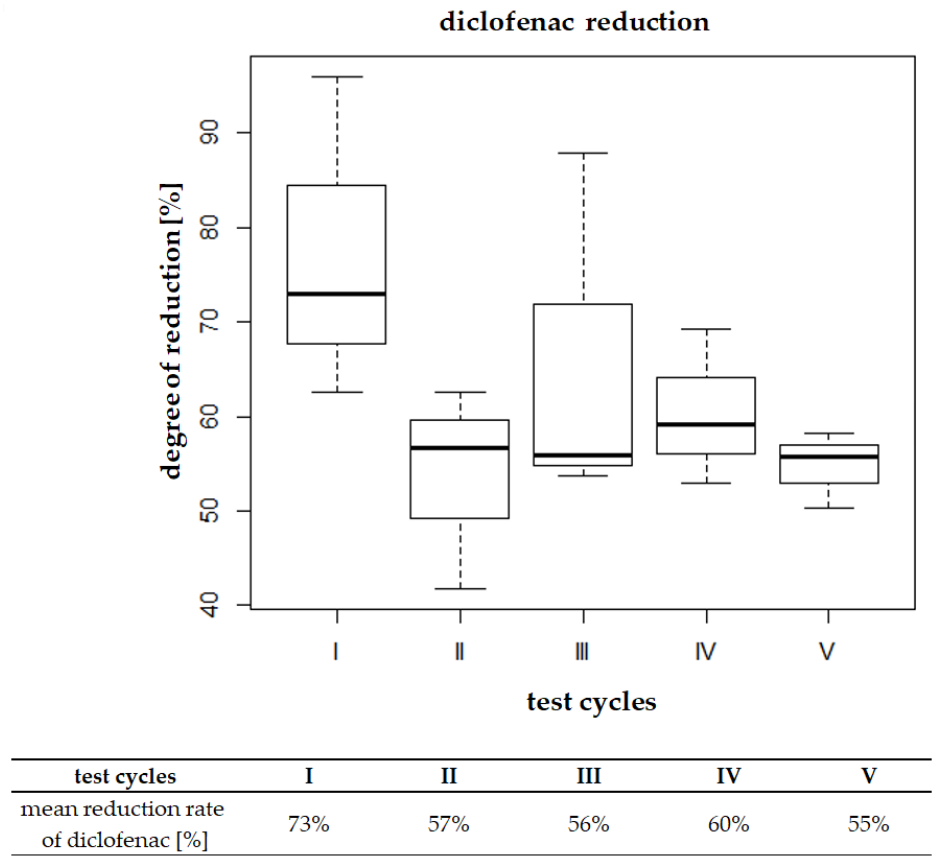
Figure 5. Distributions of diclofenac reduction concentration in cycle I of diclofenac dosing in reactor R2 in relation to individual research cycles .